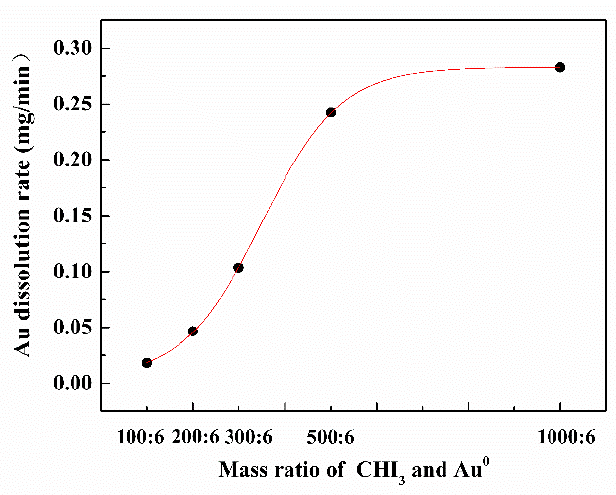
Figure 2. Variation of dissolution rate with ratio of CHI 3 and Au 0 . With the optimal ratio (CHI 3 = 0.5 g, BmimN(CN) 2 = 3 g, Au = 0.006 g), the average